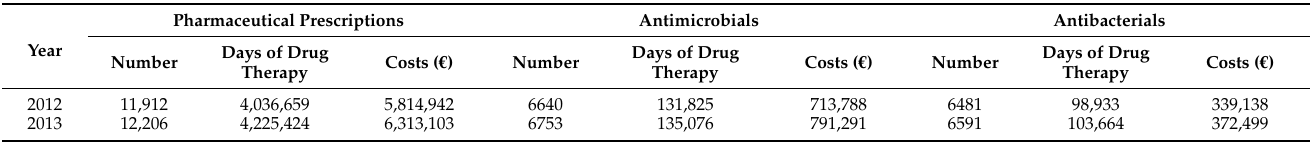
Table 6. Pharmaceutical and antibiotics prescriptions costs during the 6-month follow-up period for individuals ≥ 15 years of age in the Liguria region